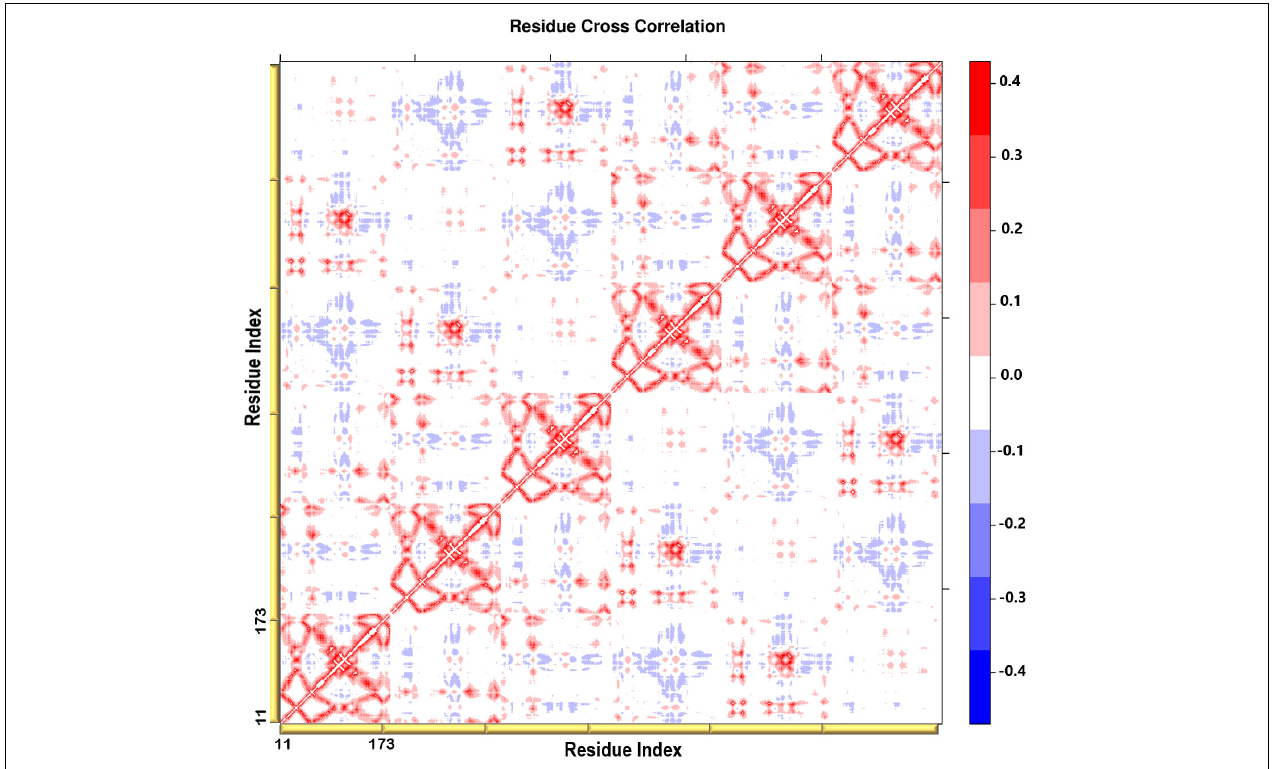
FIGURE 6 | A heatmap representation showing the C β atoms pairwise cross-correlation. The correlation matrix ranges from − 0.4 to +0.4. The scale color bar on the right indicates the extent of the correlation in which the red color highlights correlated motions (residue pairs moving together in the same direction), while the blue color highlights the anti-correlated movements (residue pairs moving in opposite direction). The yellow bars along the bottom represent each chain of the